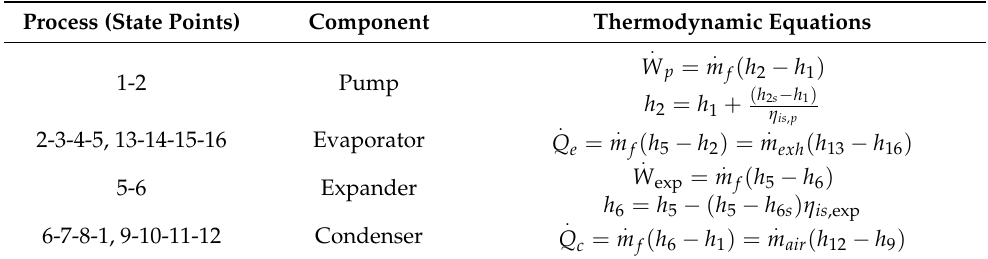
Table 6. The thermodynamic calculations for each component of the ORC system. Process (State